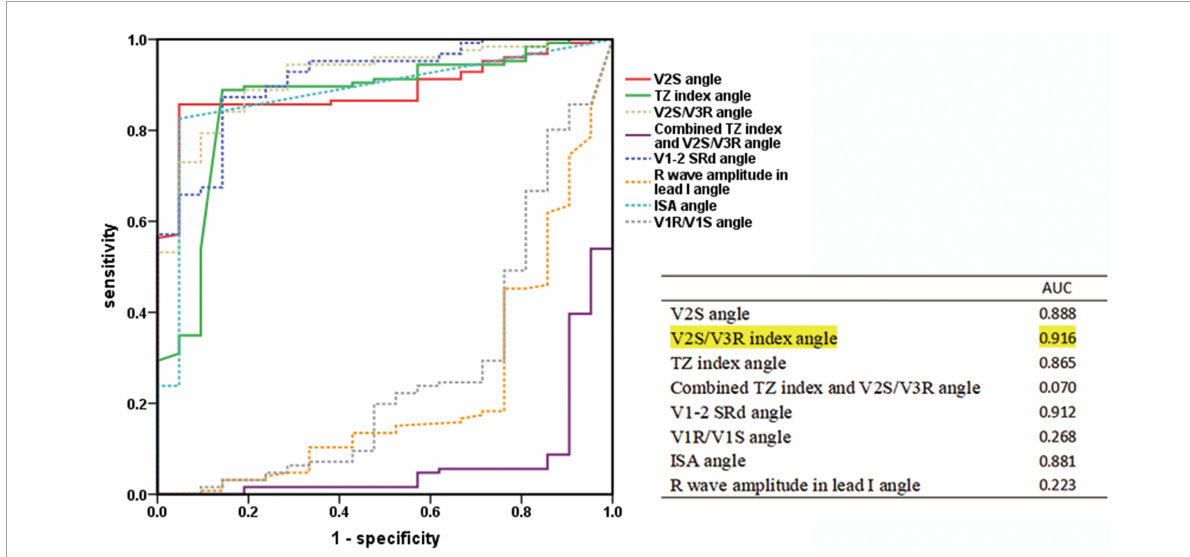
FIGURE5 Receiver operating characteristic curve analysis of the V2S angle and the angle-corrected ECG algorithms. The predictive accuracy of several ECG algorithms was improved by correcting with the angle. The AUC of the V2S/V3R index angle (AUC = 0.916) was the highest of all, even greater than that of the V2S angle (AUC = 0.888).